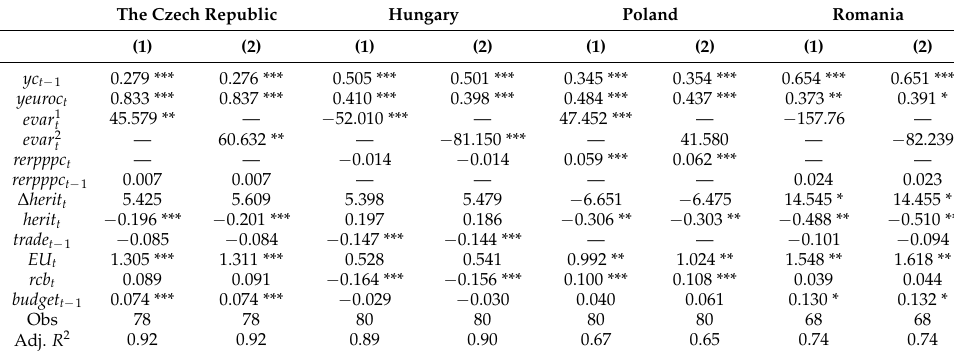
Table 10. Regression results for cyclical components of output (extended